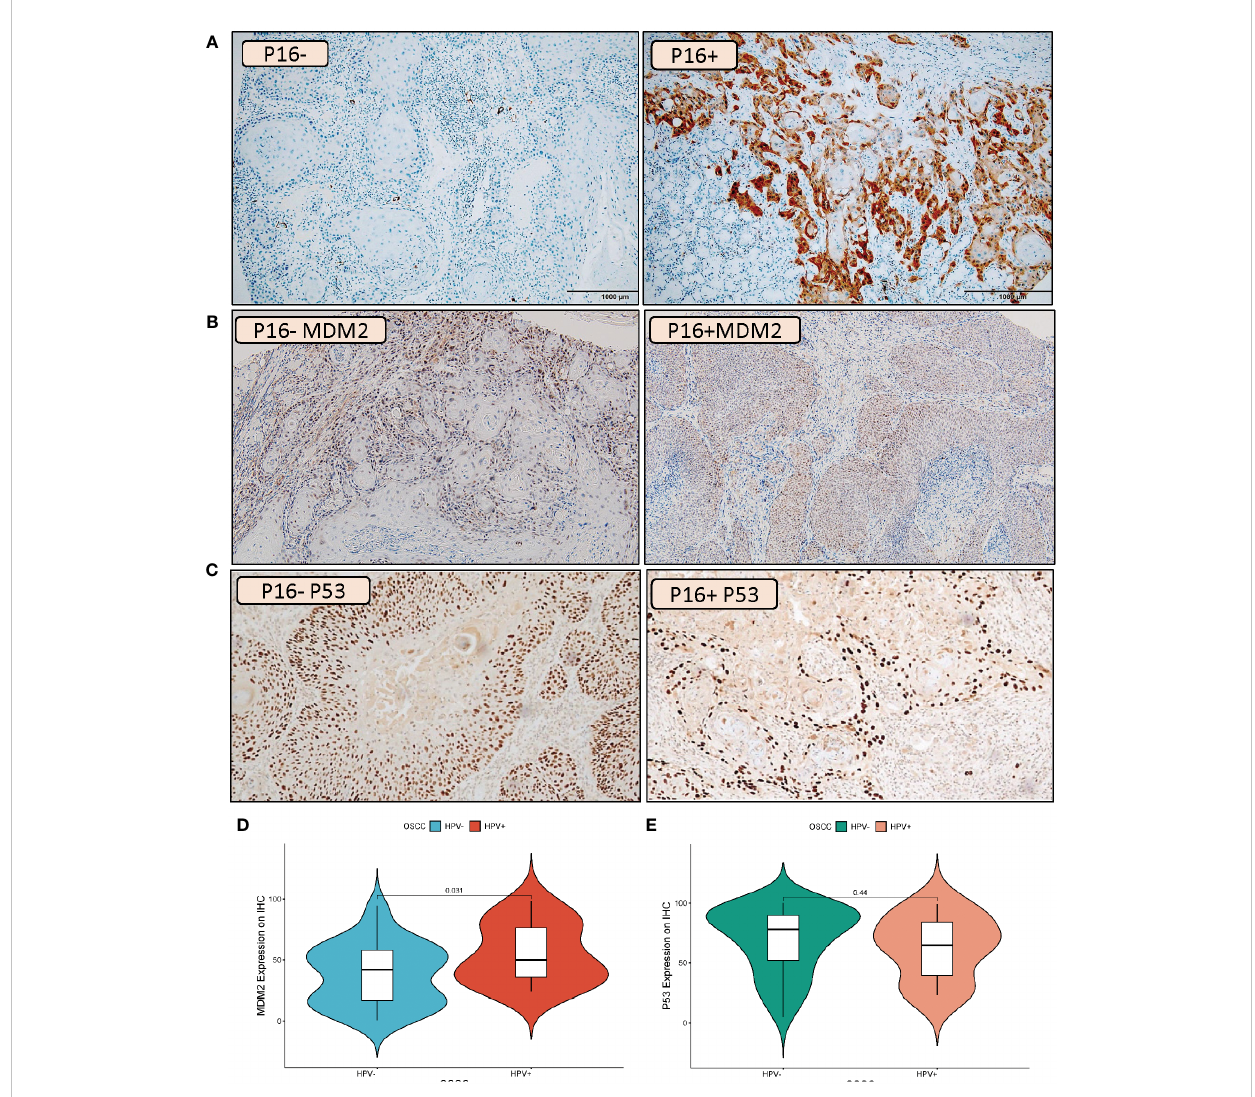
FIGURE 6 IHC Validation of the MDM2 and P53 expression levels in HPV + and HPV - OSCC patients. Example of IHC analysis (10X) of P16 (A) , MDM2 (B) and P53 (C) in oral squamous cell carcinoma patients. For MDM2, the left side of the image represents HPV - tumors which illustrate a low degree of IHC staining while the right side of the image represents HPV + tumors which indicates much more IHC staining. For P53 no distinct variation was observed between IHC staining in HPV- tumors (left side) and HPV + tumors (right side). Violin plot of MDM2 (D) and P53 (E) protein expression changes in HPV + compared to HPV - HNSCC patients. The statistically signi fi cant expression differences between HPV + and HPV - OSCC samples were evaluated using a t-test ( p <